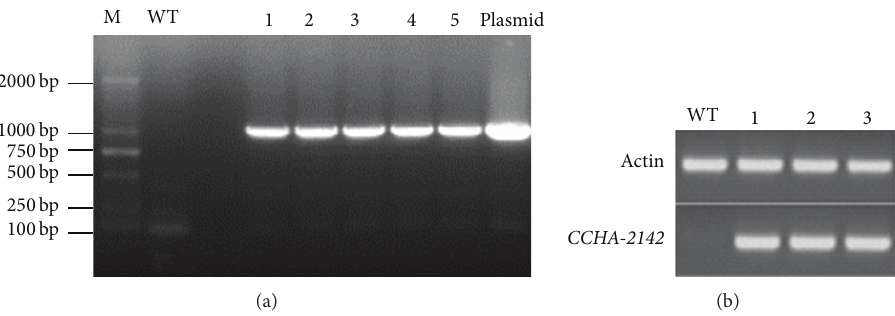
Figure 3: The identification of CCHA-2142 -overexpressing Arabidopsis thaliana . (a) PCR analysis of transgenic plants with CCHA-2142 : M means DM 2000 marker; WT means wild type; 1, 2, 3, 4, and 5 mean transgenic lines; and plasmid means positive control (plasmid pBI121G- CCHA-2142 ). (b) Confirmation of CCHA-2142 was expressed in transgenic lines by RT-PCR; WT means wild type; and 1, 2, and 3 mean transgenic